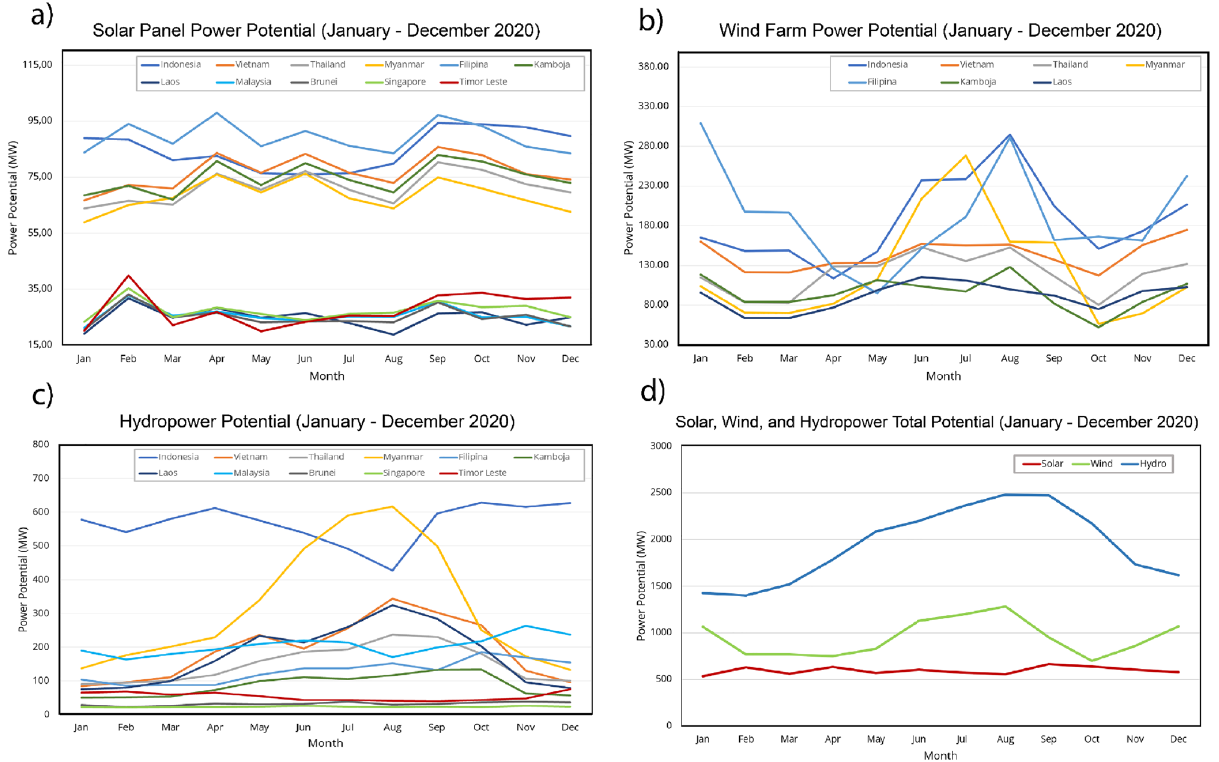
Figure 4. Country profile of monthly power potential from January to December 2020 for ( a ) solar photovoltaic (PV) power, ( b ) wind farms, ( c ) hydropower, and ( d ) the combined total for solar, wind, and hydropower in Southeast